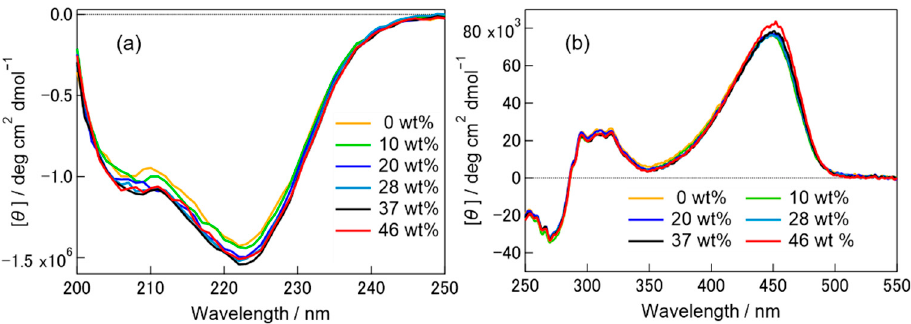
Figure 2. CD spectra of PYP in phosphate buffer (pH 8.0) containing 100 mM NaCl and various concentrations of Hy[ch][dhp] in ( a ) 200–250 nm and ( b ) 250–550 nm. Ellipticity was converted to molar ellipticity per protein.